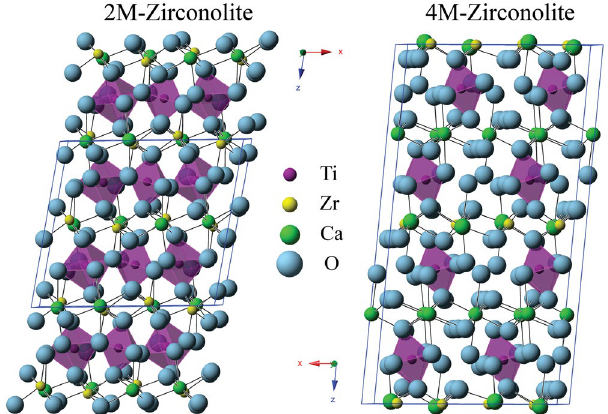
Figure 1. 2M and 4M polymorphs of zirconolite, showing only the fully occupied Ti